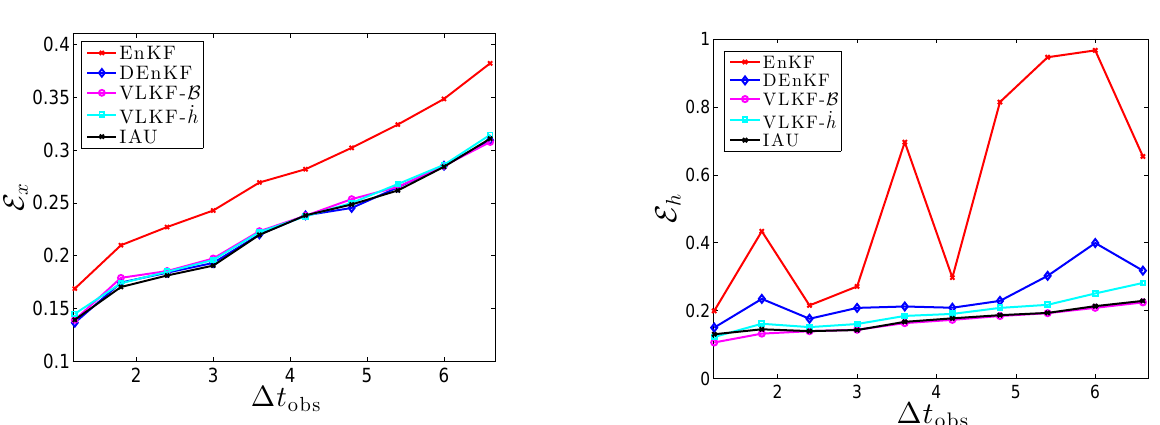
Fig. 6. Rms error of the analysis as a function of the observation interval ∆ t obs (in hours) for the unobserved height variables h .